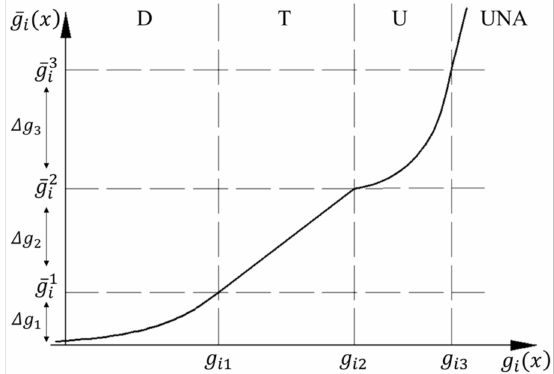
Figure 10. Class function for objectives of weight and